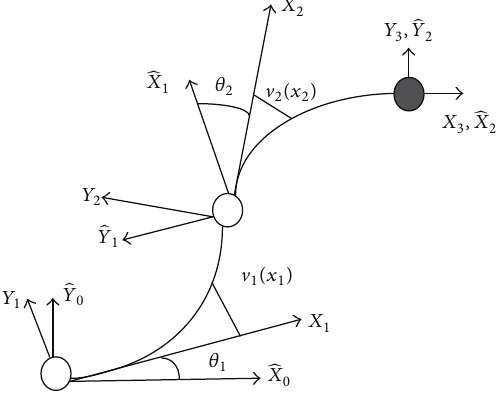
Figure 1: Two-flexible-link